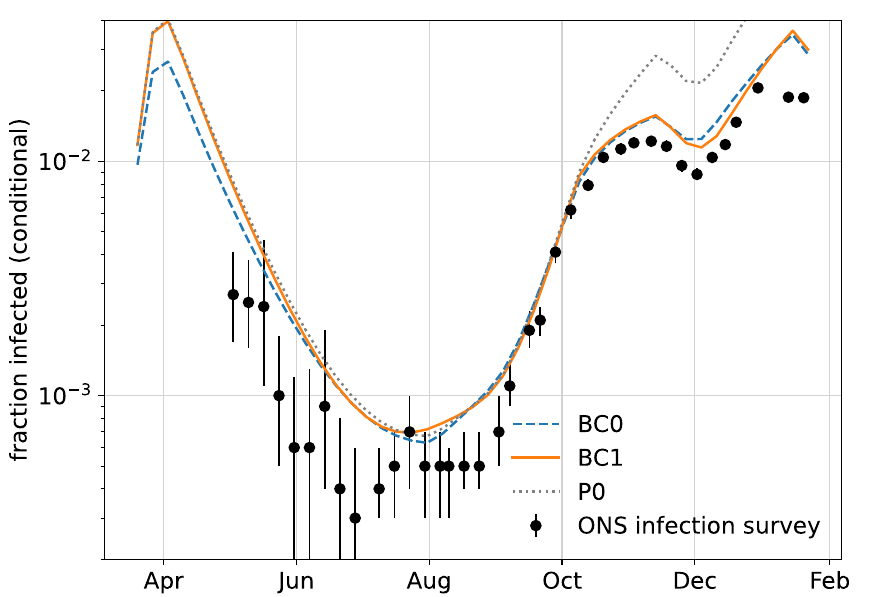
Fig 5. Estimated fraction of infected population conditional on observation. Mean fraction of people infected (symptomatic and asymptomatic) in the total population, conditional on the observation of cases and deaths in models BC0 (blue), BC1 (orange) and P0 (grey). For comparison, we also show the prevalence of infections reported in the ONS infection survey.